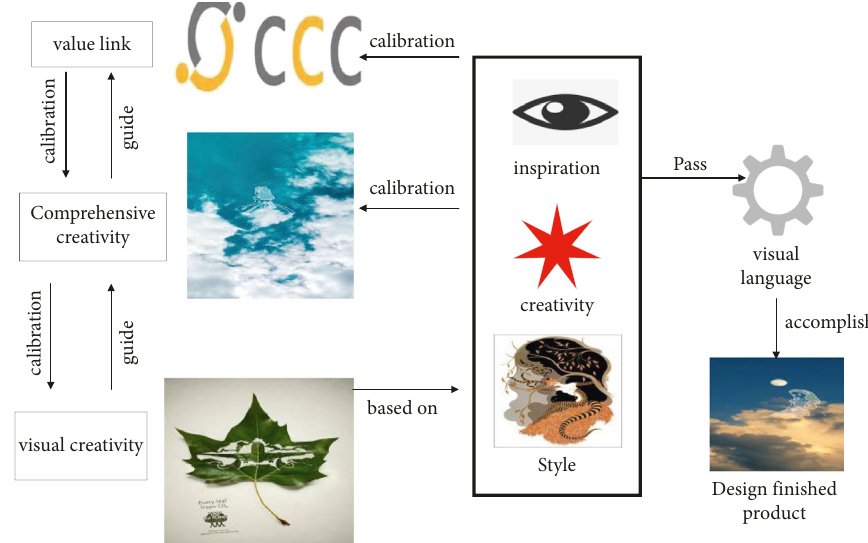
Figure 4: Visual creative link logic